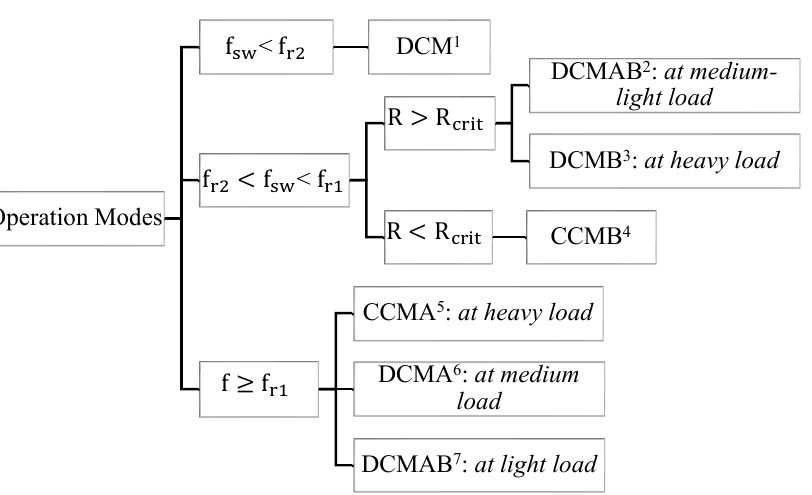
Figure 1. LLC resonant half-bridge converter.